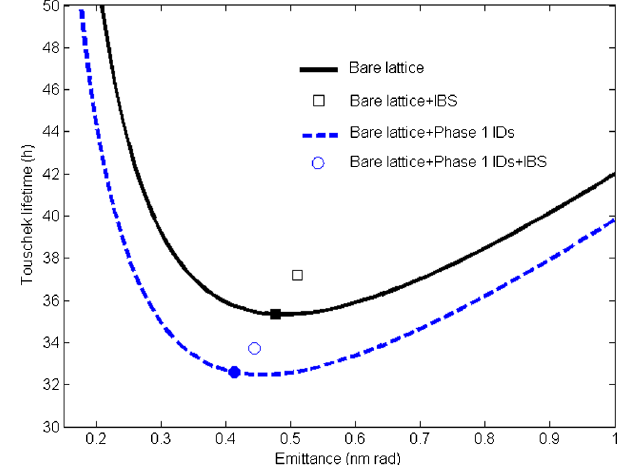
33.703FIG. 19. Touschek lifetime as a function of beam emittance for